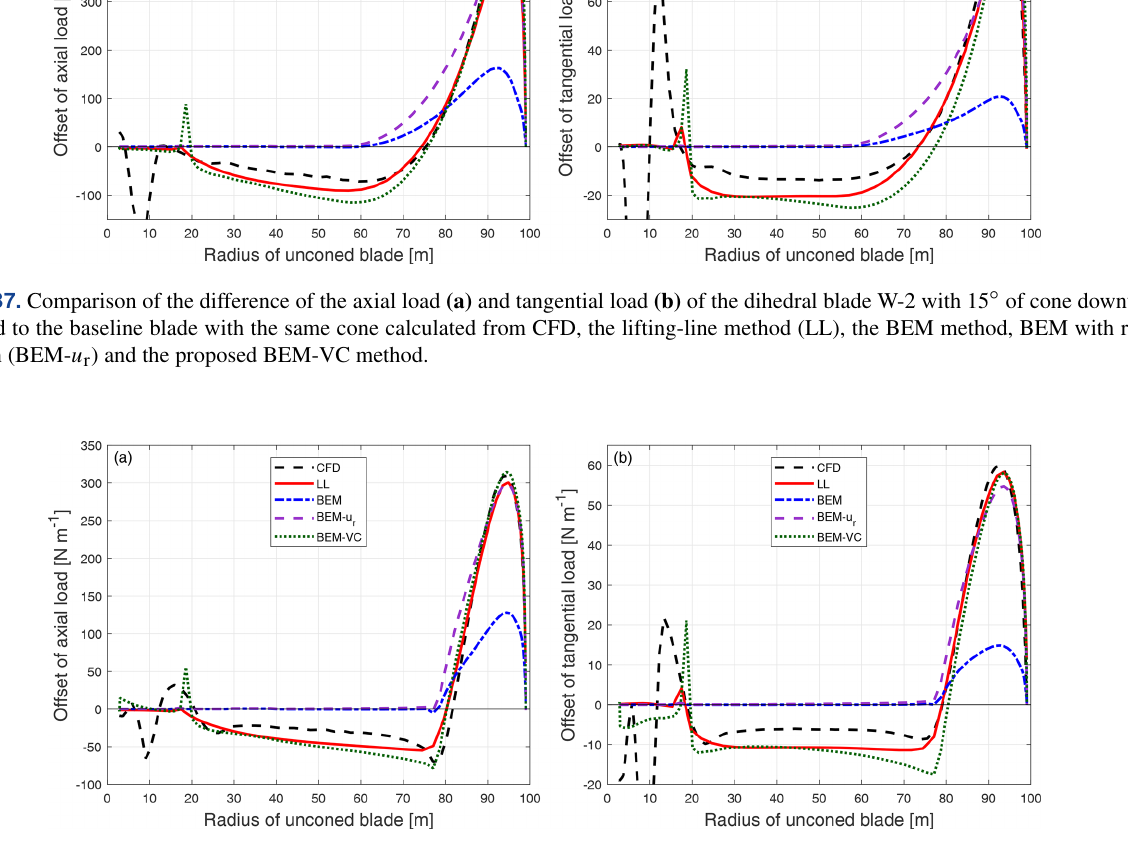
Figure B8. Comparison of the difference of the axial load (a) and tangential load (b) of the dihedral blade W-3 with 15 ◦ of cone downwind compared to the baseline blade with the same cone calculated from different aerodynamic